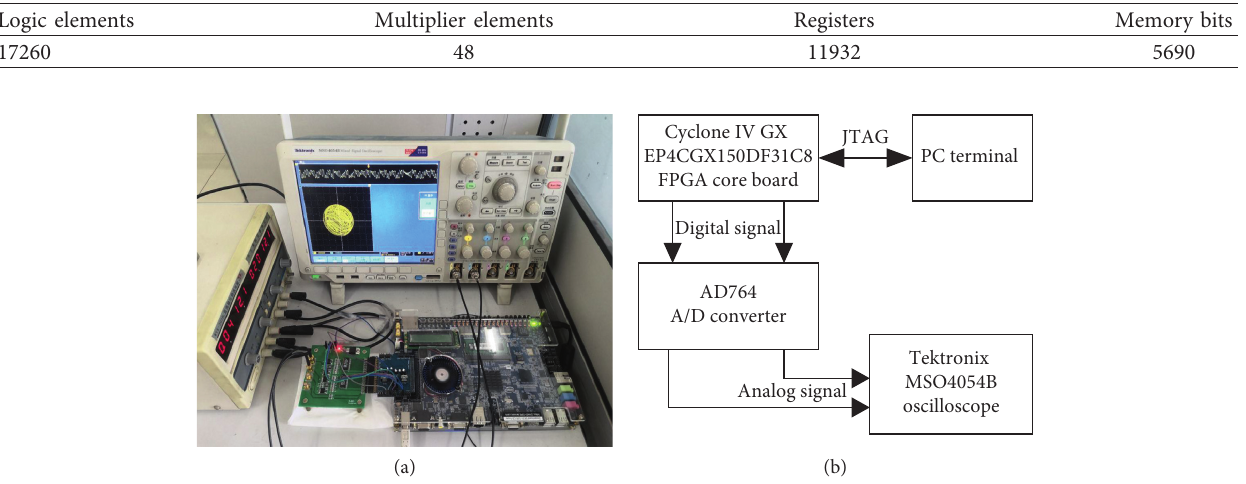
Figure 16: (a) The experimental circuit of the chaotic orbits. (b) Hardware design.